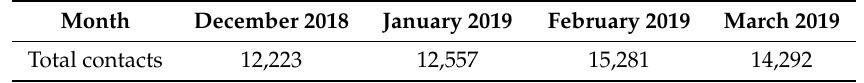
Table 4. Number of contacts taken over by employees between December 2018 and March 2019.